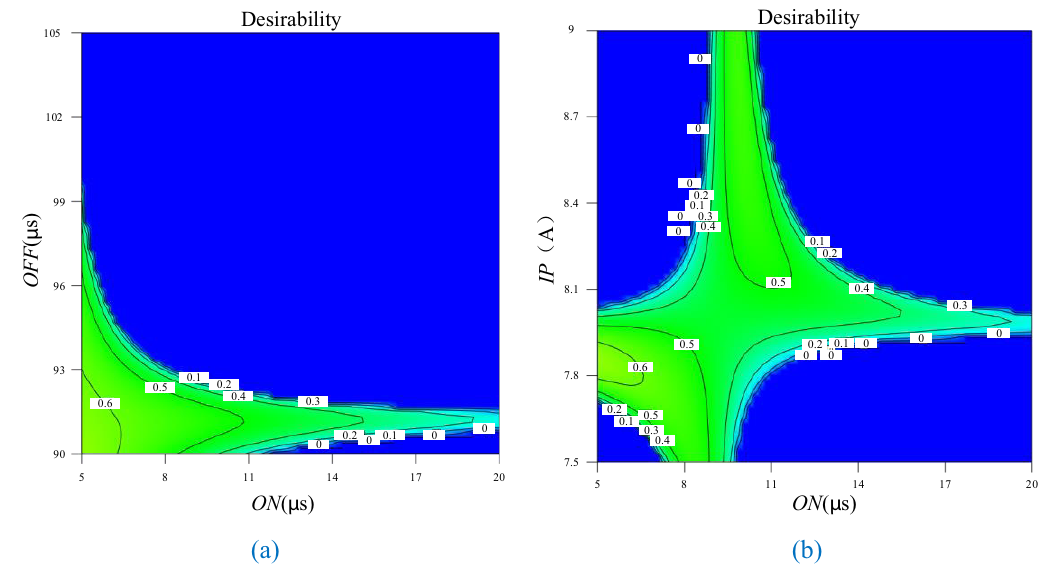
Figure 8: Desirability under di ff erent electrical parameters: ( a ) ON and SV; and ( b ) ON and